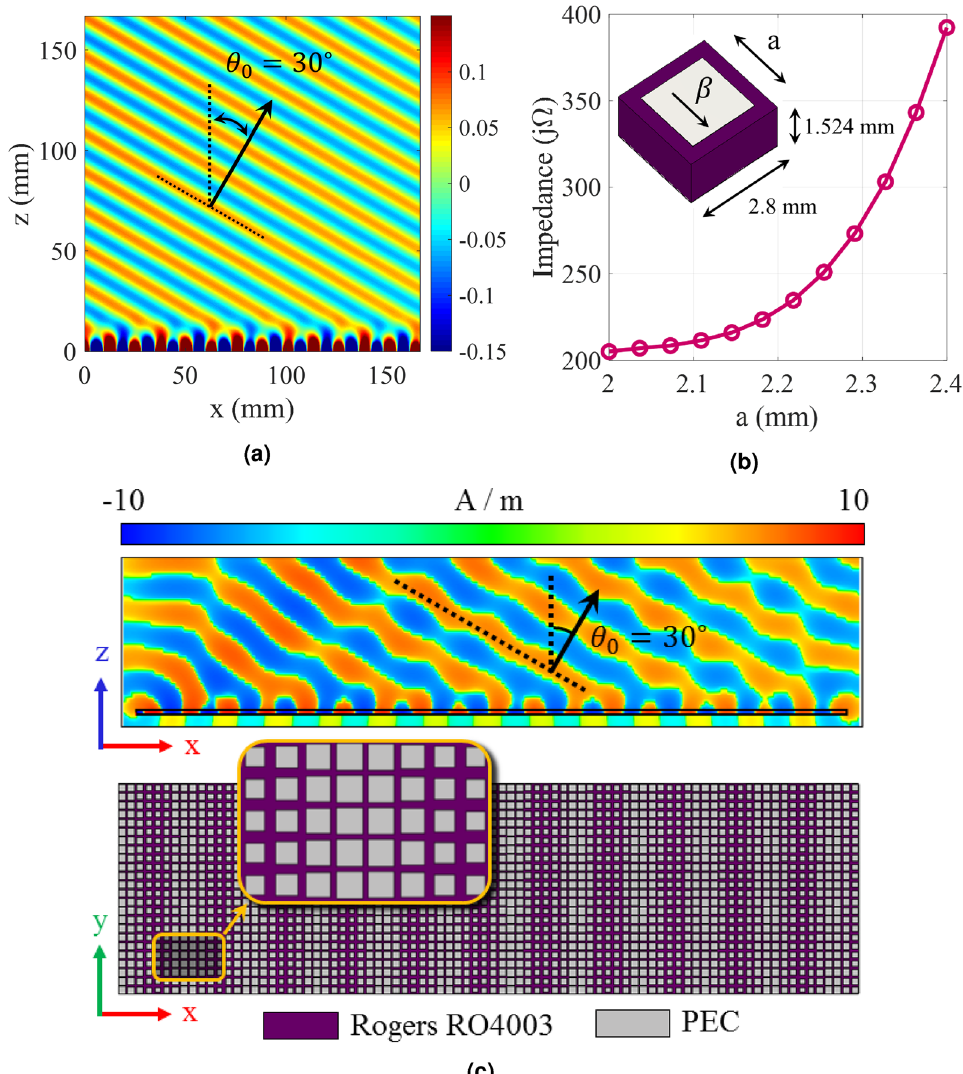
Figure 5. ( a ) Analytical results for total magnetic field at 18 GHz. ( b ) Proposed unit-cell and its equivalent surface impedance as a function of patch width. ( c ) Static hologram implemented by an quasi-periodic array of printed square